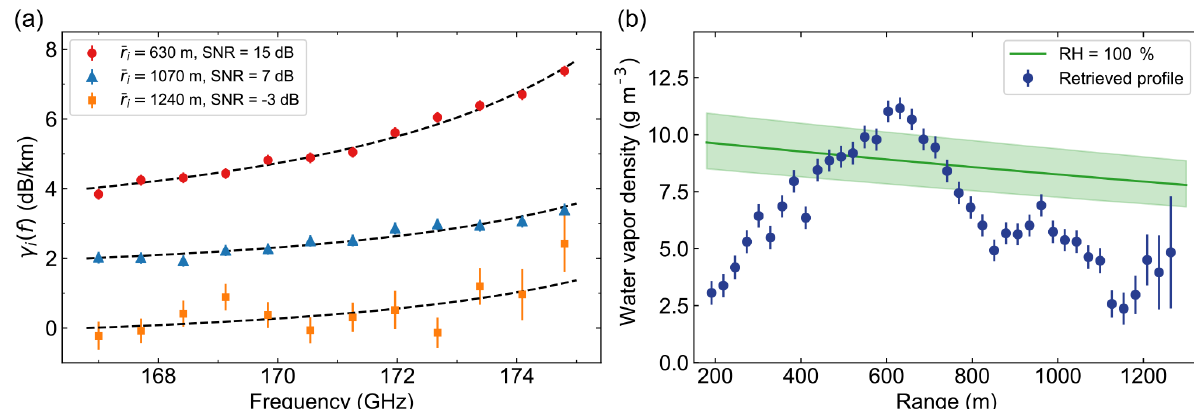
Figure 5. Water vapor profile retrieval for DAR spectra from Fig. 4. (a) Three examples of least-squares fits of the millimeter-wave propaga- tion model to DAR measurements. Artificial offsets are imposed in order to plot all three on the same graph. (b) The retrieved profile exhibits roughly constant absolute humidity error until SNR ≈ 10dB (1km). See Sects. 2.4 and 3.2 for retrieval details. The green line shows the saturated water vapor density range dependence using a near-surface temperature of 11 ◦ C and lapse rate of 6 ◦ Ckm − 1 . The shaded regions correspond to deviations of ± 2 ◦